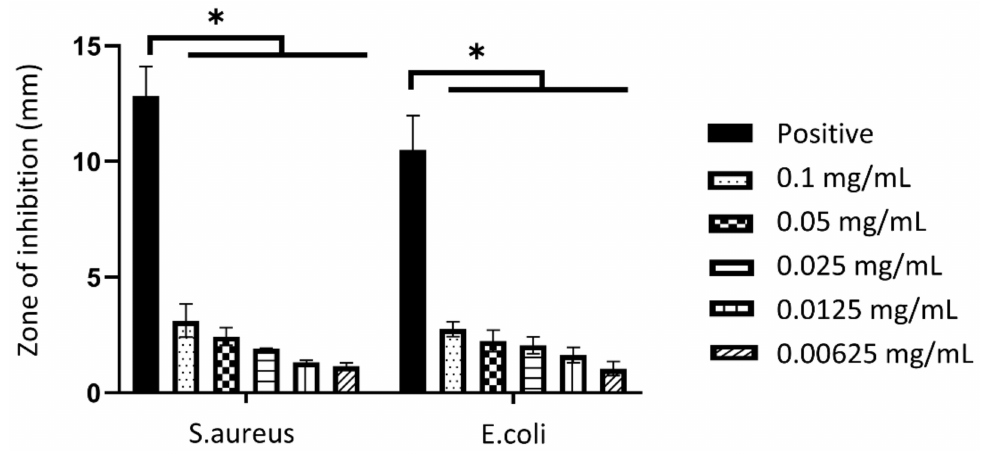
Figure 6. The antibacterial properties of hybrid graphene oxide and silver nanoparticles at 37 ◦ C. * p < 0.05 indicates the siginificant differences of the zone of inhibition caused by the